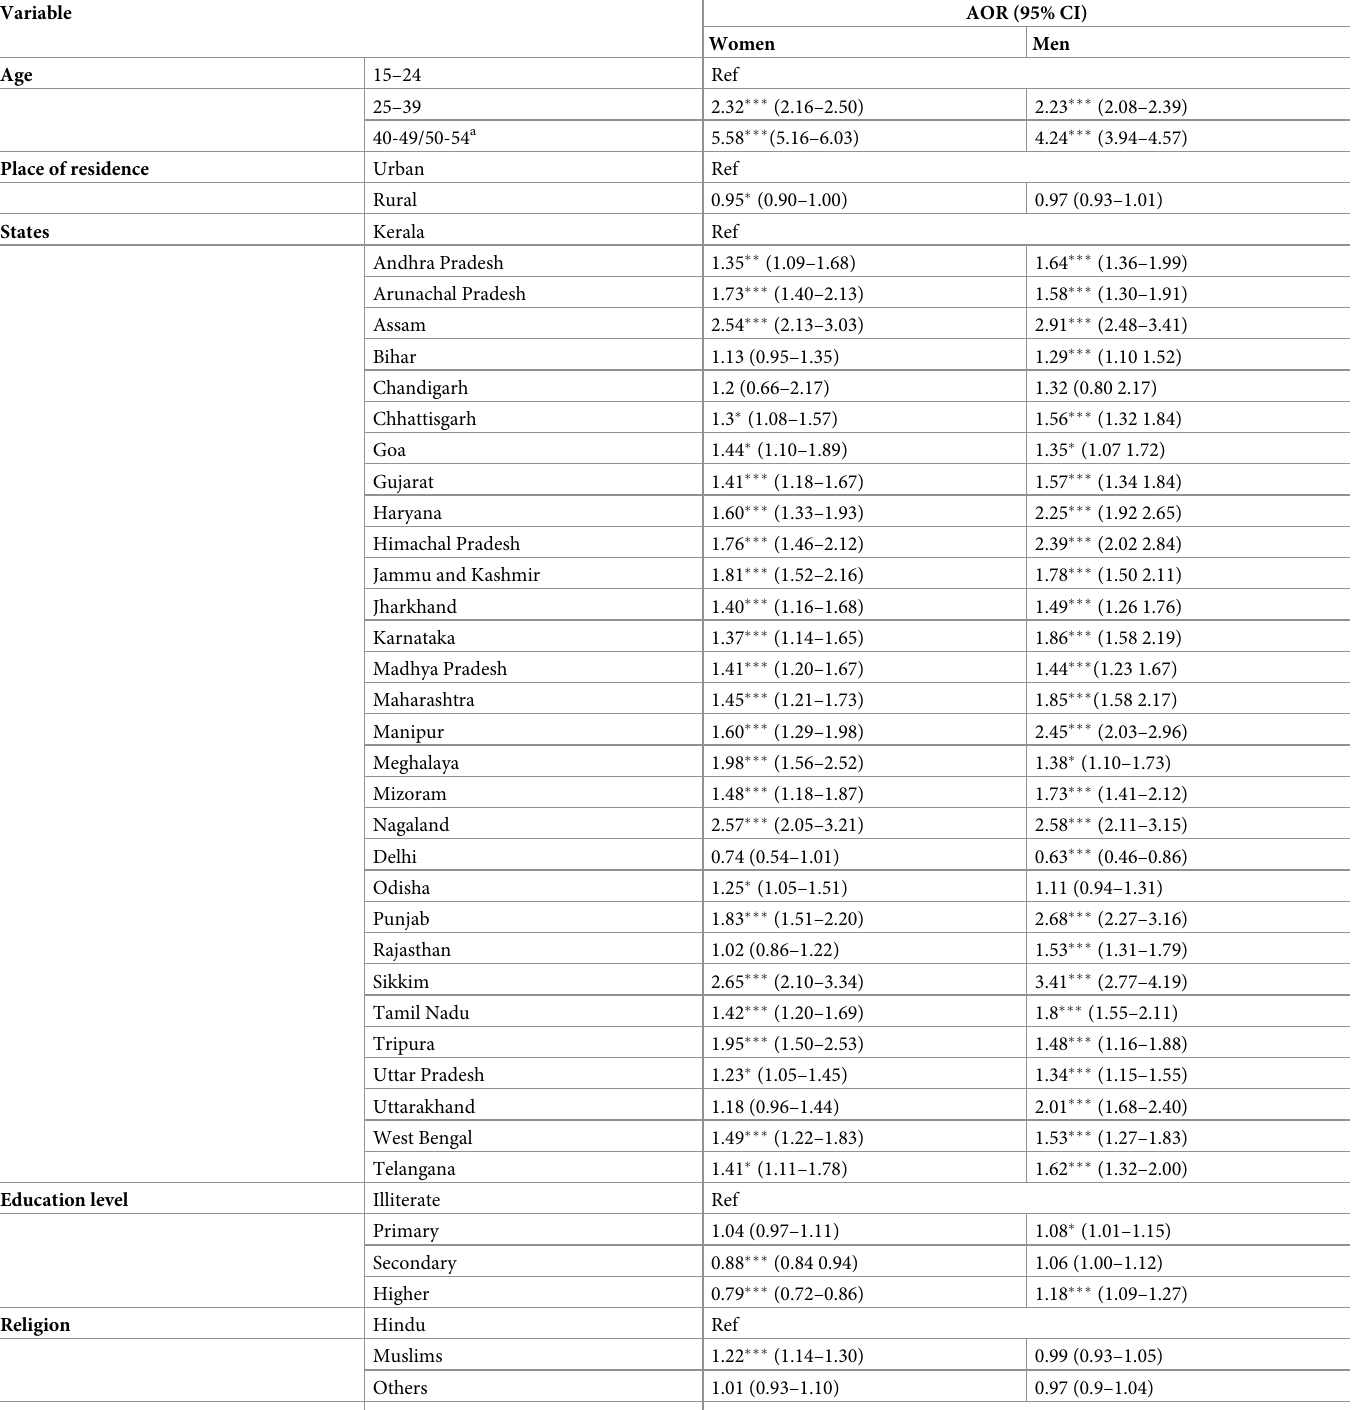
Table 2. Adjusted odds ratios (AORs) for hypertension among women and men, by demographic, socioeconomic and lifestyle